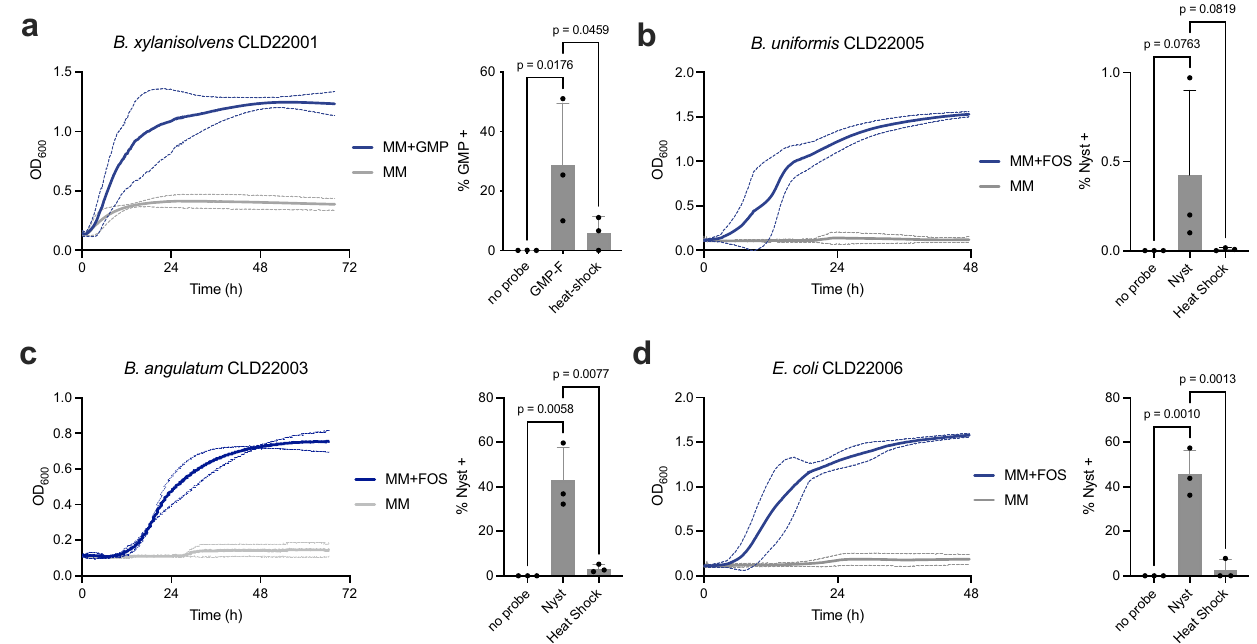
Fig. 5| Consumer bacteriafromthreemajorphyla canbeisolatedby culturing glycan + cells. a Growth of B. xylanisolvens CLD22001 in minimum medium sup- plemented or not with 0.1% galactomannopentaose. The growth curves are the mean and standard error of three independent replicates. GMP-F uptake by B. xylanisolvens CLD22001. The exponential cultures of B. xylanisolvens CLD22001 inMMsupplementedwithGMPwereincubatedfor1hwithGMP-F.Thepercentage of GMP + bacteria was measured by fl ow cytometry. Data from three independent experiments are shown asthe means±SD. Statistical signi fi cance compared to the GMP-F condition by one-way ANOVA with Bonferroni ’ s multiple comparison test.